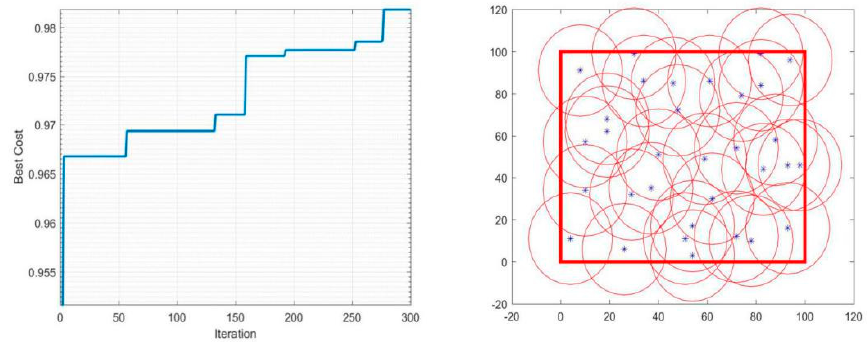
Figure 5. Coverage of 35 sensors.